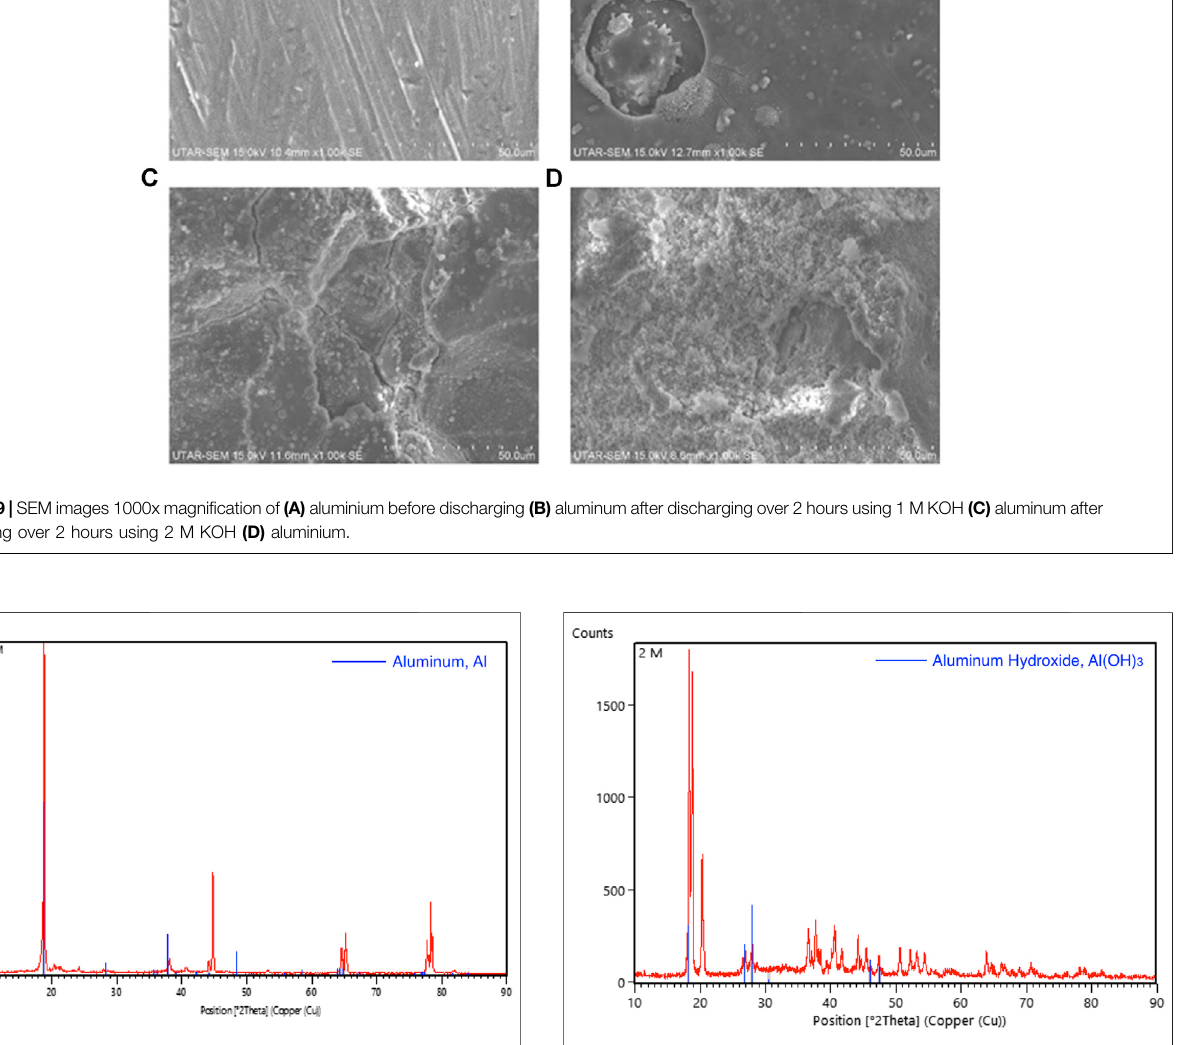
FIGURE10 | Graphic comparing the XRDpattern(red line) on aluminum foil after tested with 1 M of KOH solution with the standard aluminum XRD pattern (blue line).